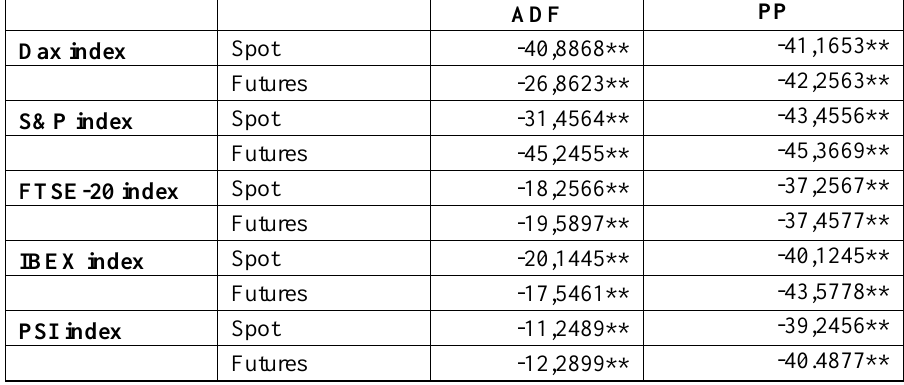
Table 3. Results of the Unit-Root Tests on Spot and Futures Prices